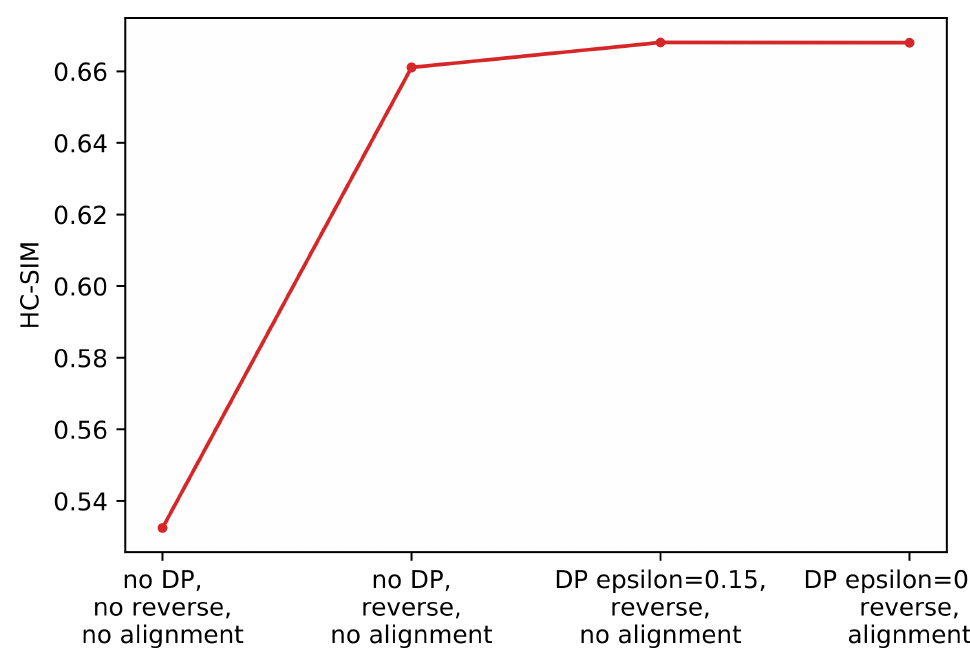
Figure 2. Average HC-SIM over whole data set for the algorithm after introducing additional